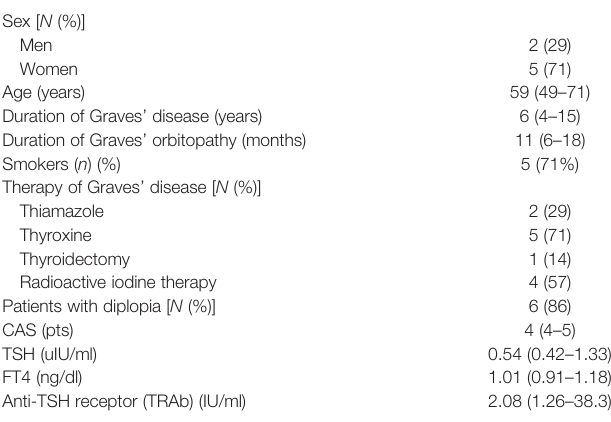
TABLE 1 | Baseline patients ’ clinical